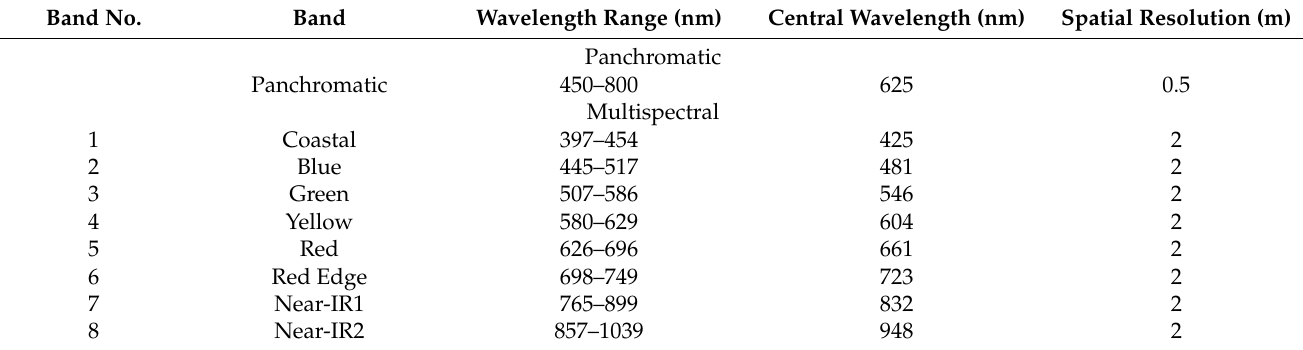
Table 1. Spectral, spatial and radiometric characteristics of the sensors onboard WorldView-2 satellite. Band